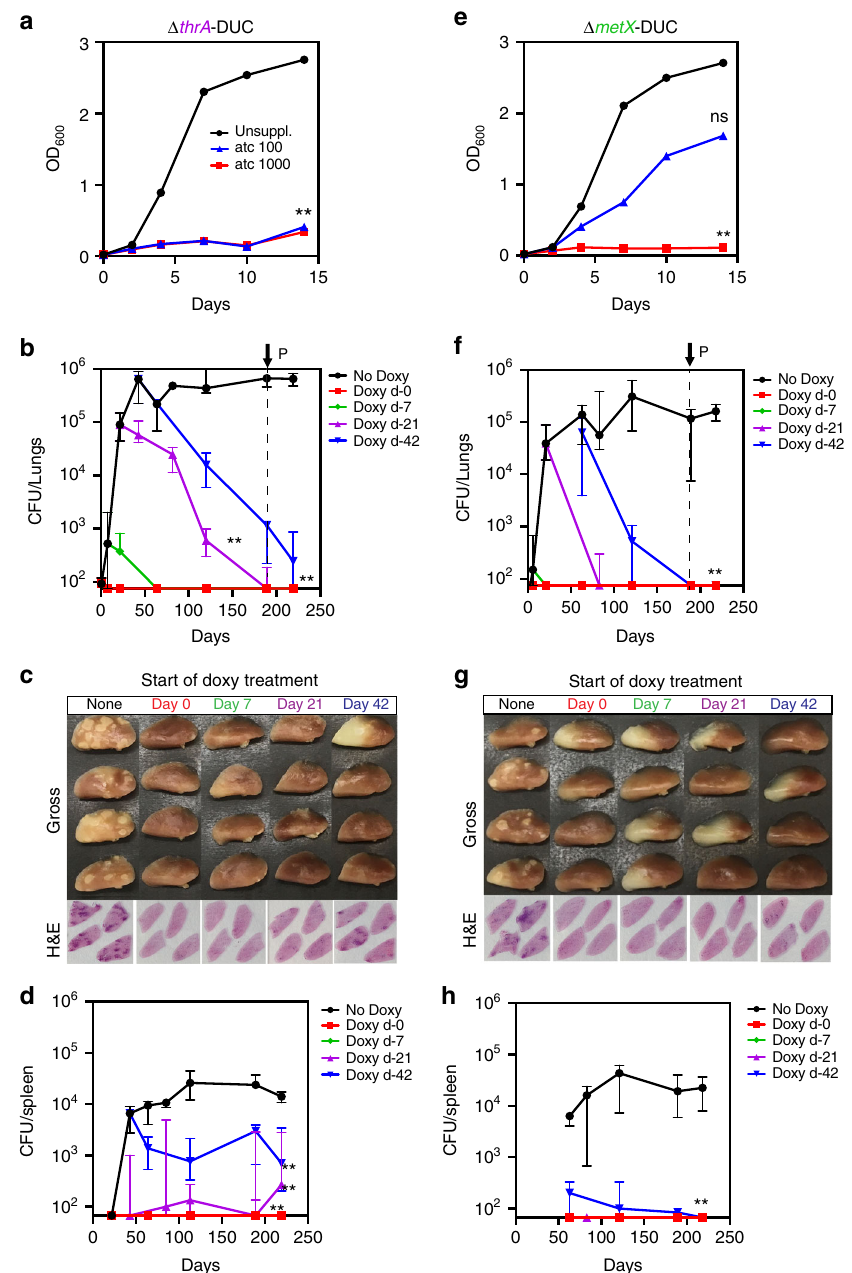
Fig. 6 Aspartate pathway enzymes are essential during acute and chronic mouse infections. Conditional knockdowns were constructed of two enzymes of the aspartate pathway: homoserine dehydrogenase ( Δ thrA -DUC) ( a – d ) and homoserine transacetylase ( Δ metX -DUC) ( e – f ). a , e Effect of gene knockdown/protein degradation on growth was tested in vitro in unsupplemented 7H9 OADC with different concentrations of anhydrotetracycline (atc). b , f Mice were aerosol infected with either Δ thrA -DUC3 or Δ met -DUC5 to deliver ~100 CFU/lungs. Groups of mice were switched to doxycycline containing chow (2000 ppm) at day 0 (red square), day 7 (green diamond), day 21 (purple triangle) and day 42 (blue inverted triangle) to induce knockdown. One group (black) was left untreated throughout the whole experiment. At given time points, 4 mice per group were sacri fi ced and bacterial burden of lungs ( b , f ) and spleens ( d , h ) determined by CFU counts of homogenized, serially diluted tissue. Gross lung pathology and Hematoxylin and Eosin (H&E) staining of lungs at day 189 are shown under ( c , g ). X -axis crosses Y -axis at limit of detection. Error bars show standard deviations from n = 4 mice. ** p -value < 0.01, * p -value < 0.05 in Student's t-test. Source data are provided as a Source Data fi was inhibited in both knockdown strains (Fig. 6a, b). Next we concentrations of atc on growth of the recombinant strains in tested the vulnerability of Mtb to inhibition of these enzymes culture broth media (Fig. 6a, e). Growth of the DUC strains in during different stages of infection in C57Bl/6 mice. Cohorts of medium without atc was indistinguishable from the parental each infection group were started on doxycycline at 0, 1, 3, or strain, demonstrating genetic complementation to WT levels 6 weeks after infection, which allowed us to study the in vivo (Supplementary Fig. 12a). While the parental H37Rv strain essentiality of these enzymes during both the acute and chronic showed no sensitivity to atc (Supplementary Fig. 12b), growth